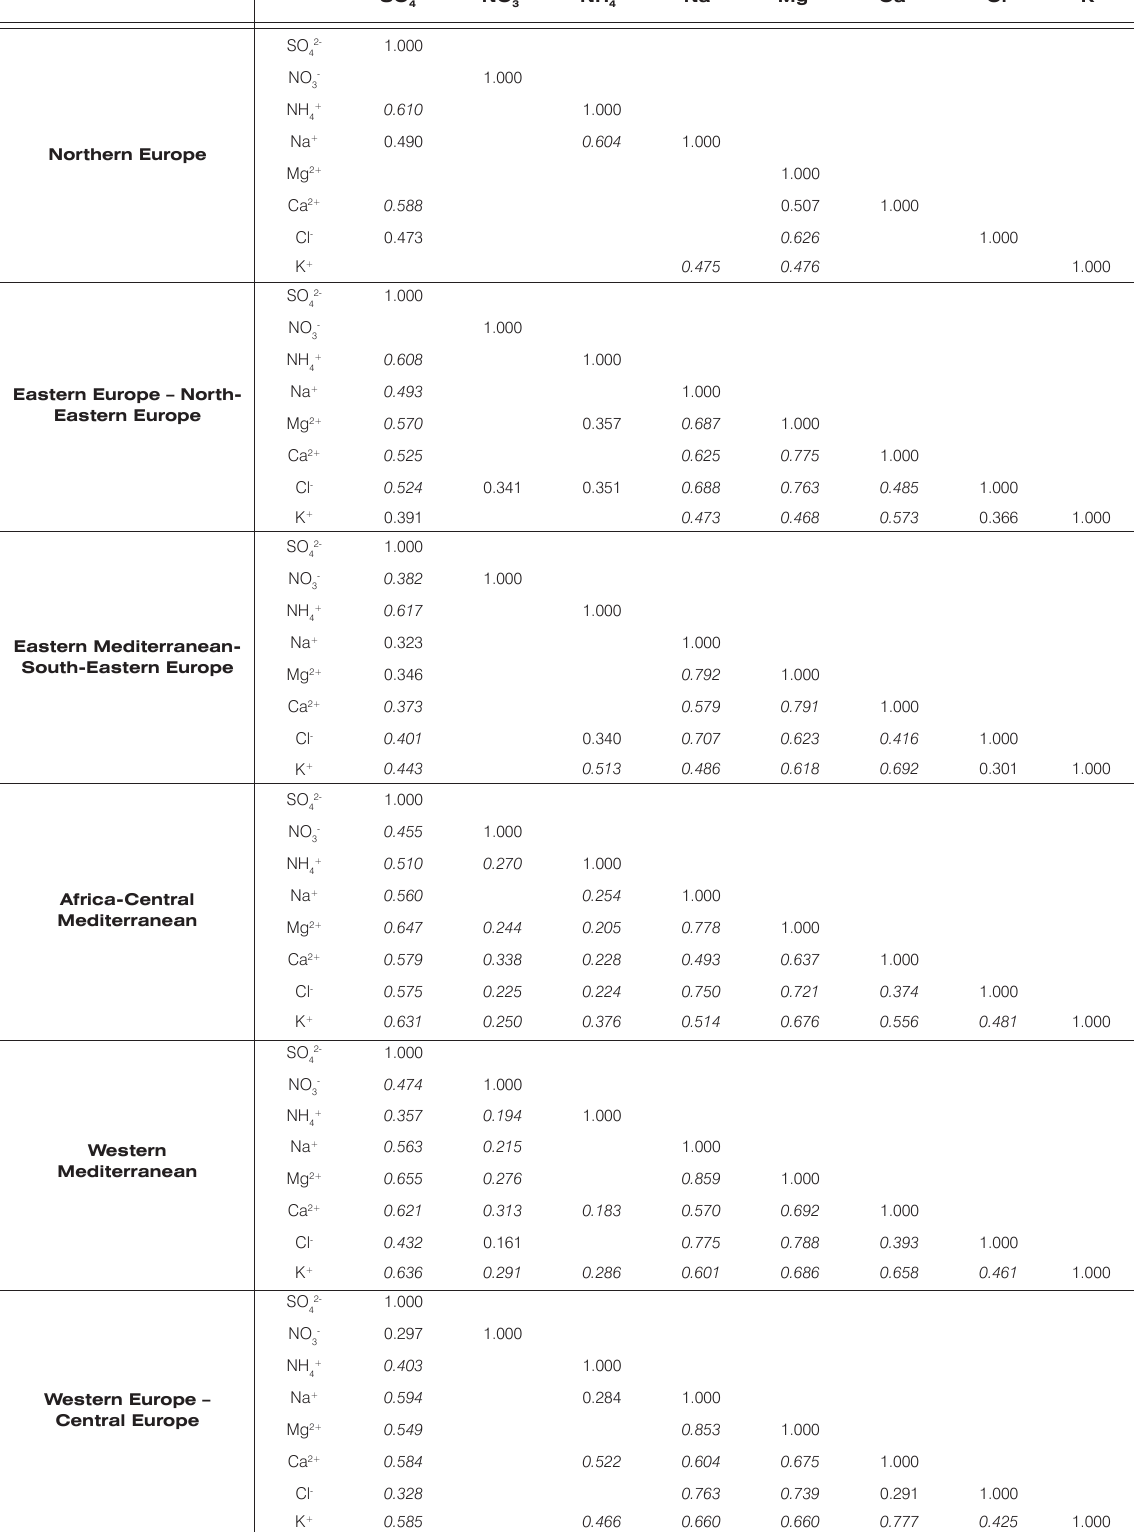
Table 3. Spearman coefficients of correlations between species on 99% confidence levels (values in italic) and on 95% confidence levels. SO